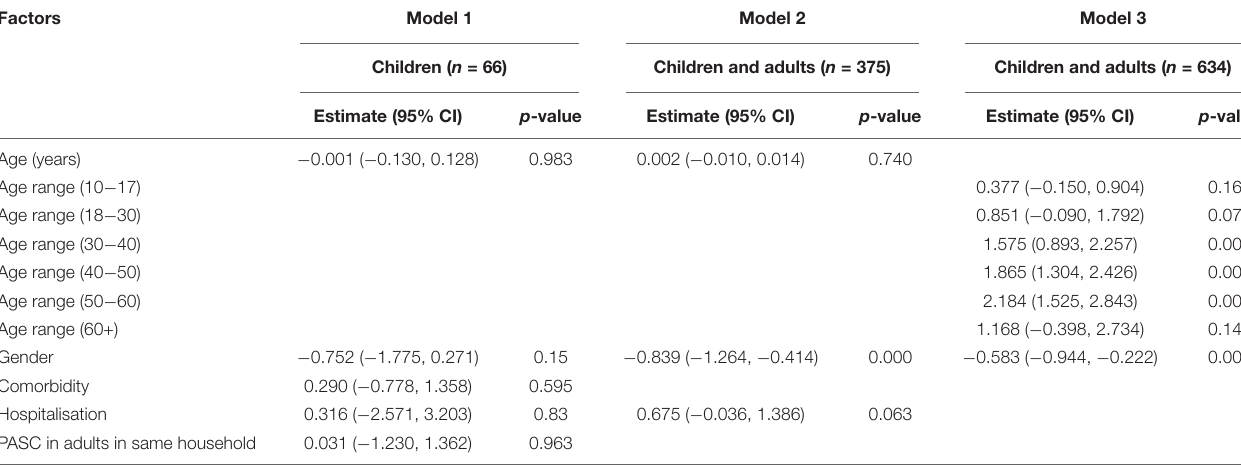
TABLE 6 | Evaluation of risk factors using logistic regression.